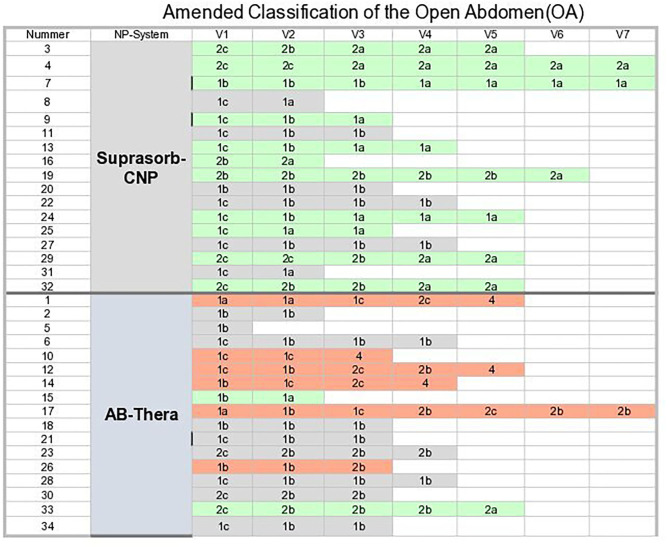
Summary of the “Amended open abdomen classification.” Green, decreasing OAC grades; Gray, constant OAC grades; Orange, increasing OAC-grades.